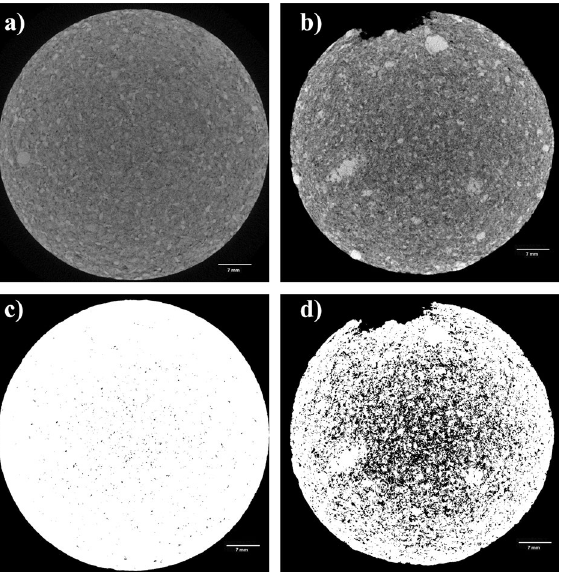
Figure 16. 2D analysis of the samples’ tomography images. ( a ) Before rock degradation, ( b ) after rock degradation, ( c ) identification of pores within the rock matrix before degradation, and ( d ) identification of pores within the rock matrix after degradation.